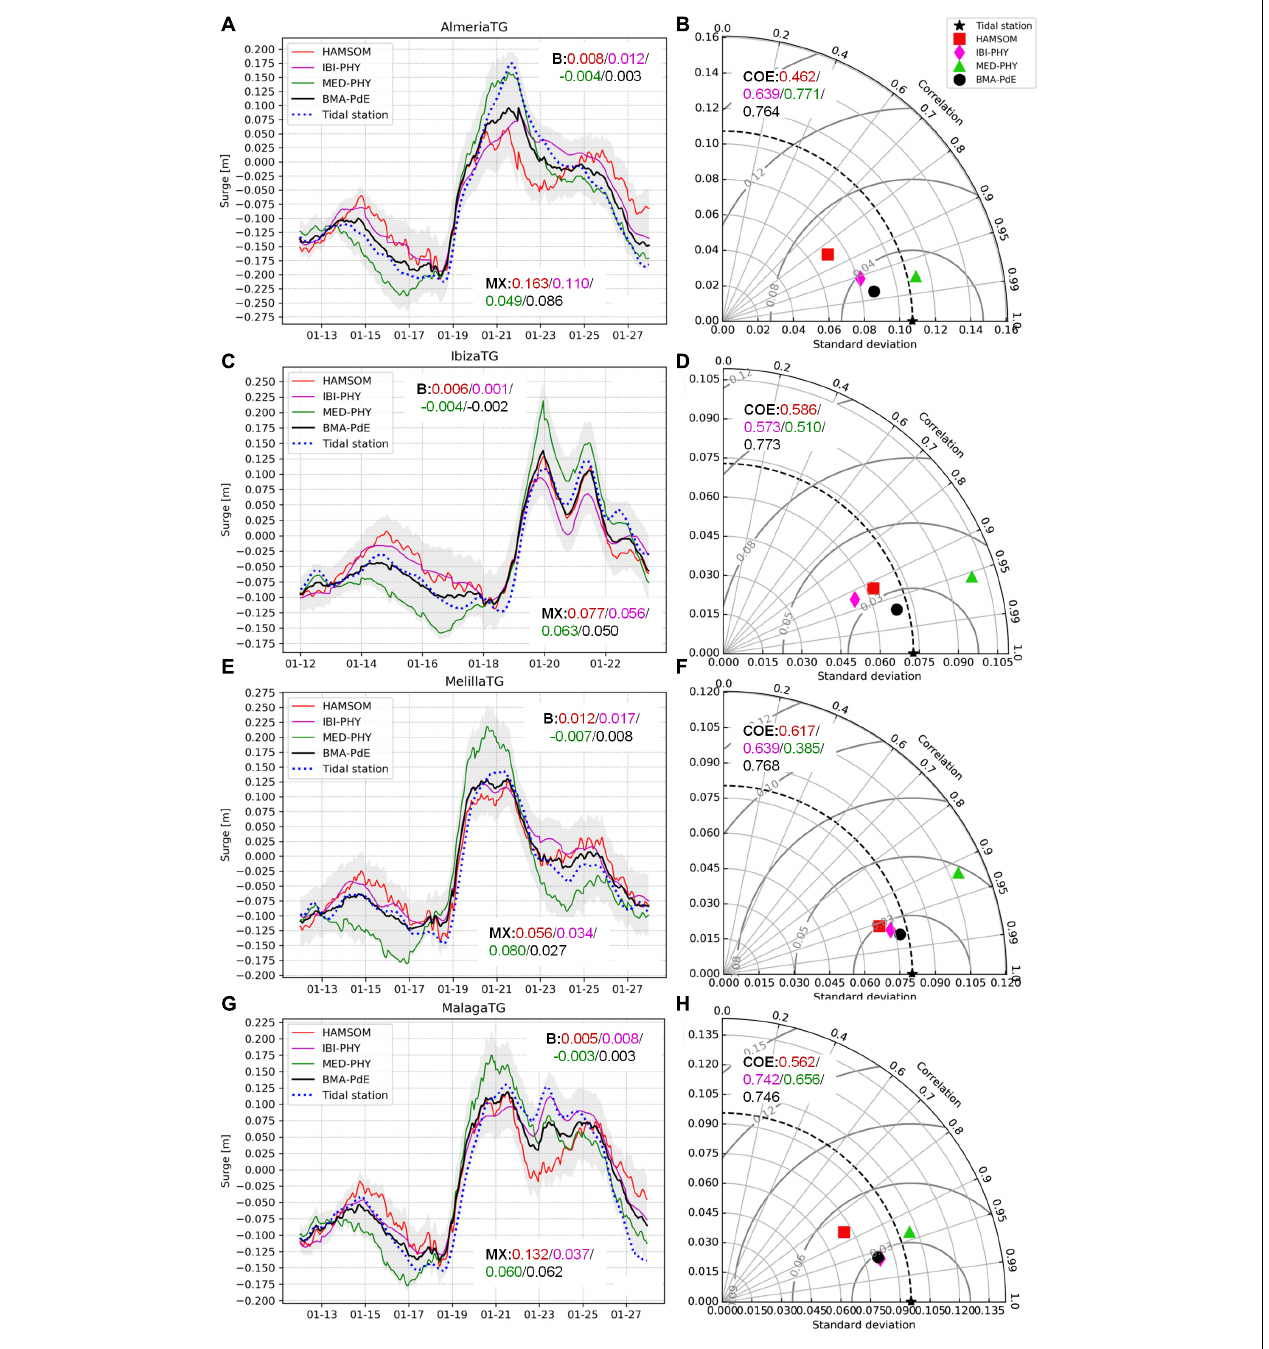
FIGURE 10 | Results of the ENSURF system at several TGs during the storm Gloria: Nivmar (red), IBI-MFS (magenta), MedFS (green), BMA-PdE (black) and observations (blue). Left panels: surge time series at Almería (A) , Ibiza (C) , Melilla (E) , and Málaga (G) . B is the mean bias for each model, in meters (same chromatic index). MX is the maximum error, in meters. The gray areas enclose the 5-95th percentiles of the ENSURF system. Right panels: Taylor diagrams at Almería (B) , Ibiza (D) , Melilla (F) , and Málaga (H) . Legend: Nivmar (red square), IBI-MFS (magenta rhombi), MedFS (green triangle), BMA (black dot). COE is the Coefficient of Efficiency for each model